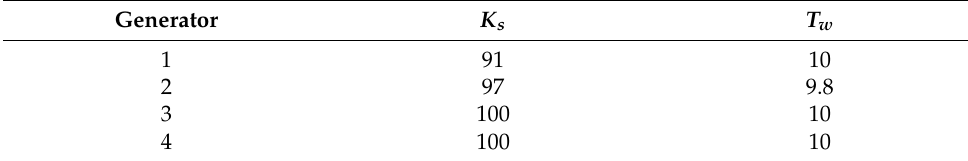
Table 3. Gains of Generator controller.